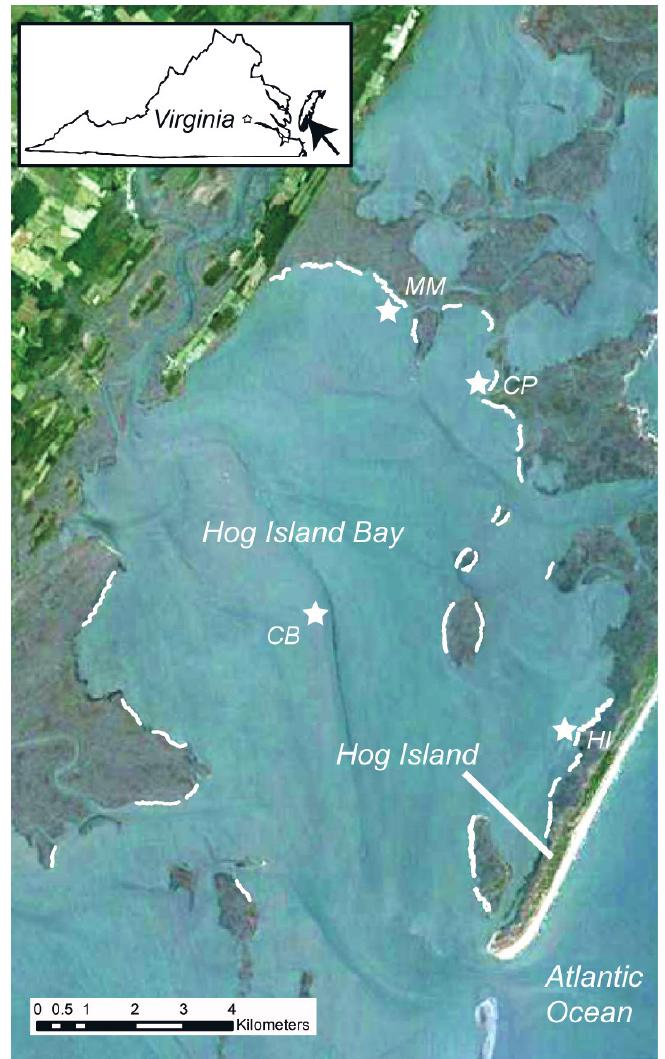
Figure 2. Marshes in Hog Island Bay, part of the Virginia Coast Reserve, Virginia, USA. HI is Hog Island Marsh; CP is Chimney Pole Marsh, MM is Matulakin Marsh. Central Bay (CB) is the position where a wave gauge was deployed. White segments indicate marsh boundaries where erosion rates were measured with aerial